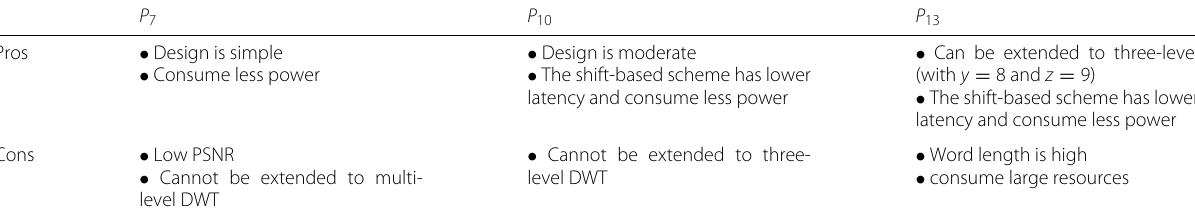
Table 8 A comparison between RNS-based implementations using moduli-set P n P